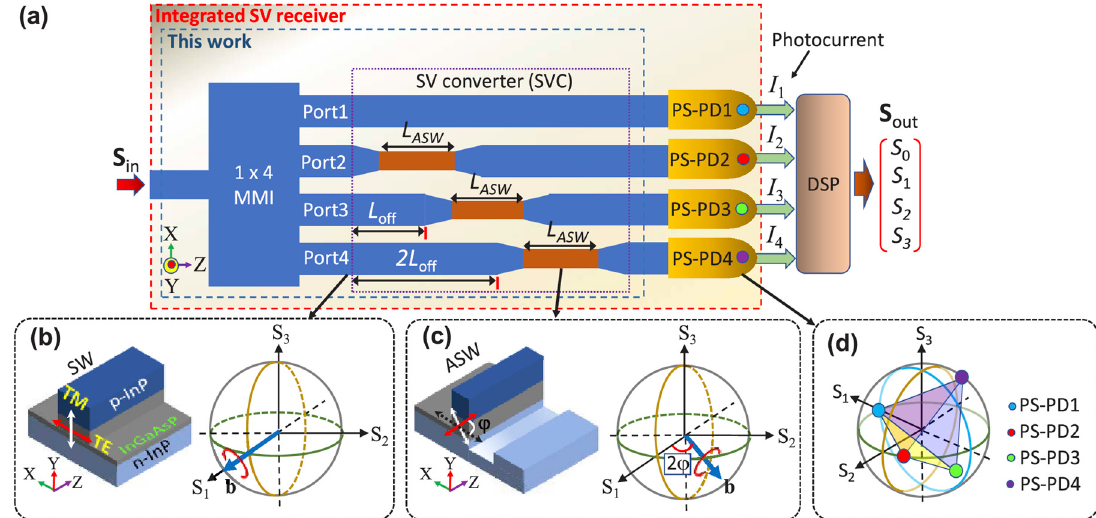
Figure 7. ( a ) Schematic top-view (XZ-plane) of the integrated Stokes vector receiver on InP; ( b ) symmetric waveguide (SW) and ( c ) asymmetric waveguide (ASW) used in the receiver; ( d ) illustrations of four basis vectors on the Poincaré sphere; MMI: multimode interference; SV: Stokes vector; PS-PD: polarization-selective PD; TE: transverse-electric; TM: transverse-magnetic; (From [106] © 2021 OSA).